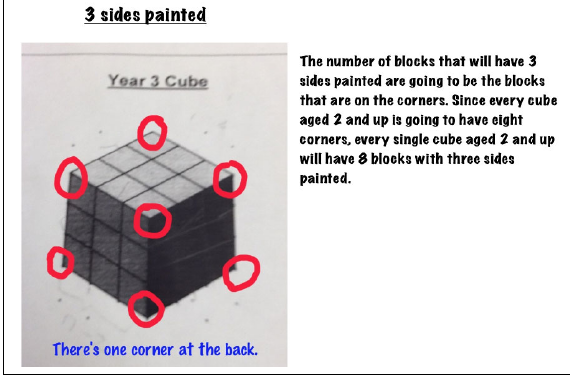
Figure 5. Sample of student presentation of a part of the solution of the